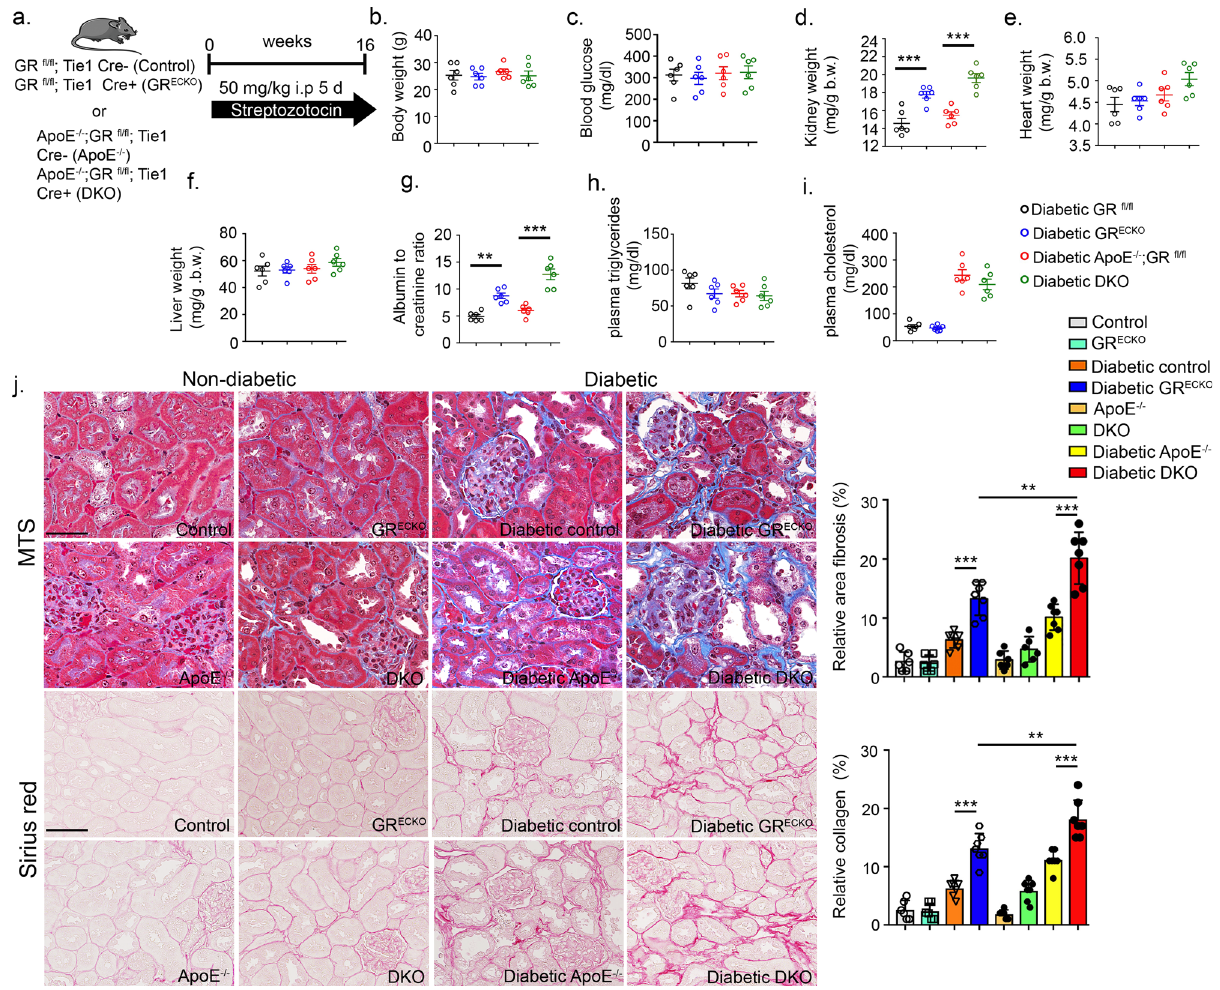
Fig. 2 Loss of endothelial GR worsens renal fi brosis in diabetic mice. a Schematic diagram, showing induction of diabetes in GR fl / fl ; Tie1 Cre − (Control). GR fl / fl ; Tie1 Cre + (GR ECKO ), Apoe; − / − GR fl / fl ; Tie1 Cre − ( Apoe − / − ) and Apoe; − / − GR fl / fl ; Tie1 Cre + (DKO) mice. Five doses of STZ (50 mg/kg/day IP) were injected to induce diabetes and renal fi brosis. b – i Physiological parameters including body weight, blood glucose, kidney weight/body weight, heart weight/body weight, liver weight/body weight, albumin-to-creatinine ratio (ACR), plasma triglycerides, and plasma cholesterol were measured. N = 6 biologically independent mice/group from two separate experiments. j Masson trichome and Sirius red staining in kidneys of nondiabetic and diabetic control, GR ECKO , Apoe − / − , and DKO mice were analyzed. Representative images are shown; original magni fi cation ×300. Relative area of fi brosis (%) and relative collagen (%) were measured using the ImageJ program. N = 7 biologically independent mice/group from two separate experiments. Scale bar 50 µ m. Data are mean ± SEM. For all panels, two-way ANOVA was used for the analysis of statistical signi fi cance. Signi fi cance * p < 0.05, ** p < 0.01, *** p < 0.001. Source data are provided in the source data fi le. Components of this fi gure were created using Servier Medical Art templates, which are